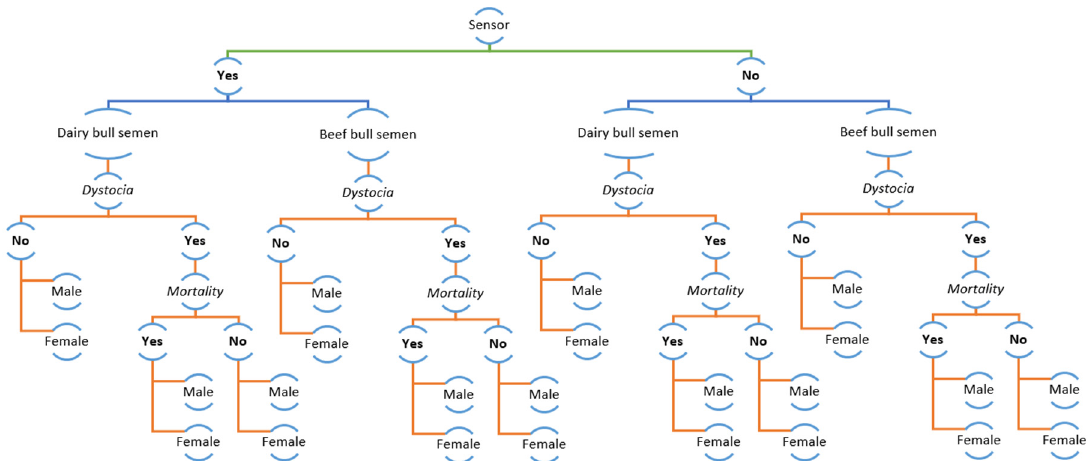
Figure 7. Summary of decision-tree for the application of calving sensor in pluriparous cows. Each point reported in the figure, such as dairy bull semen and dystocia, represents a binary option based on data reported in Table 1. Data cannot be represented due to the very large size of the